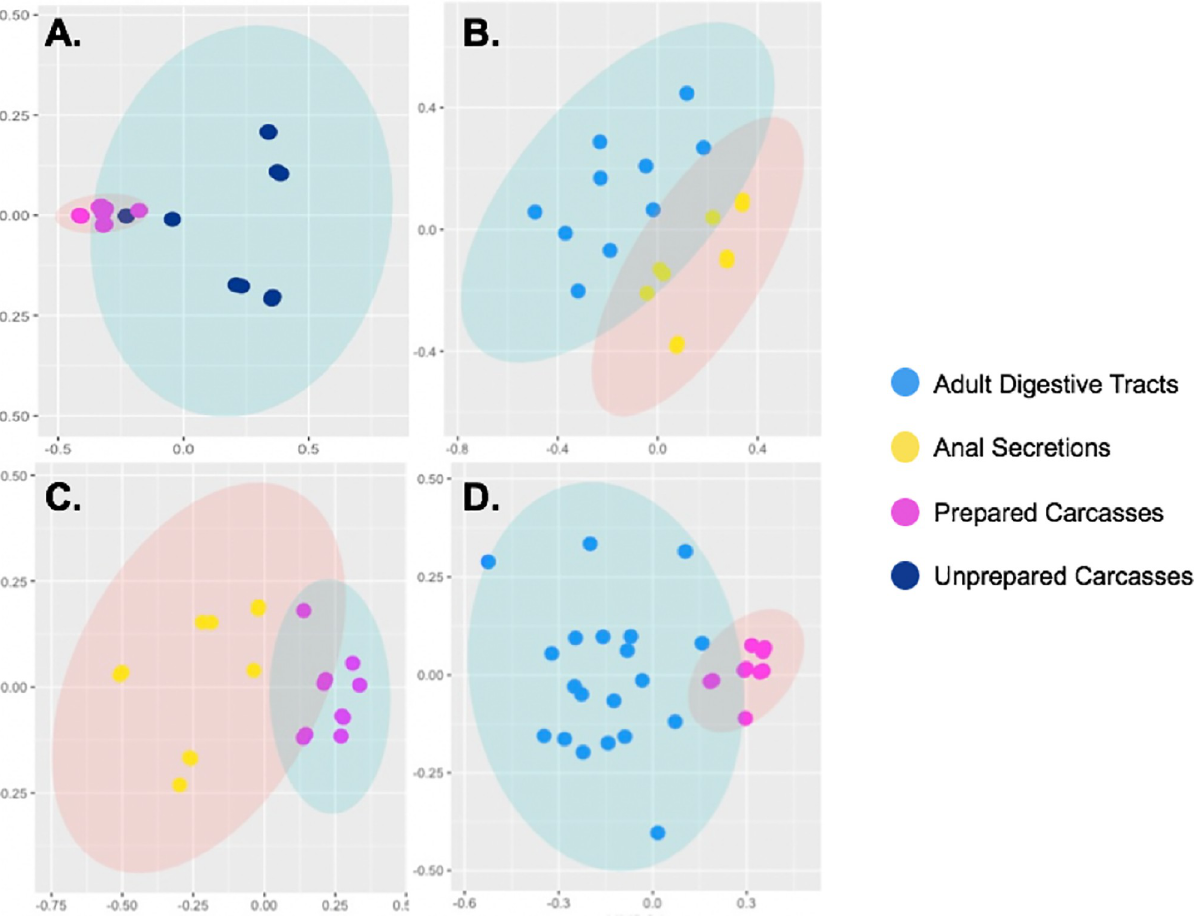
Fig 3. Detrended correspondence analysis (DCA) of sample bacterial communities. Ordination plots depicting significant different clustering patterns (ANOSIM p < 0.05) between: A) unprepared vs. prepared carcasses, B) adult digestive tracts vs. the anal secretions, C) anal secretions vs. prepared carcasses, and D) adult digestive tracts vs. prepared